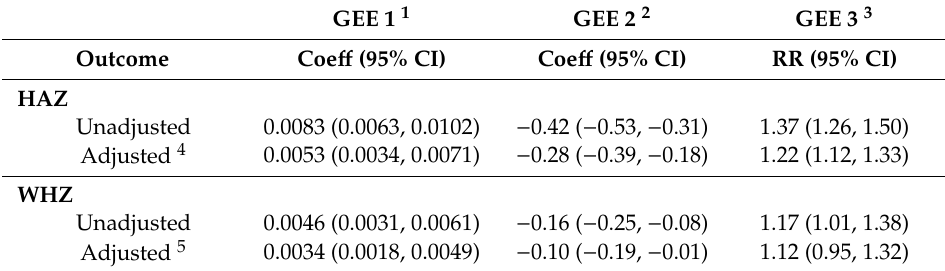
Table 2. Association between plasma total cysteine and selected repeated anthropometric